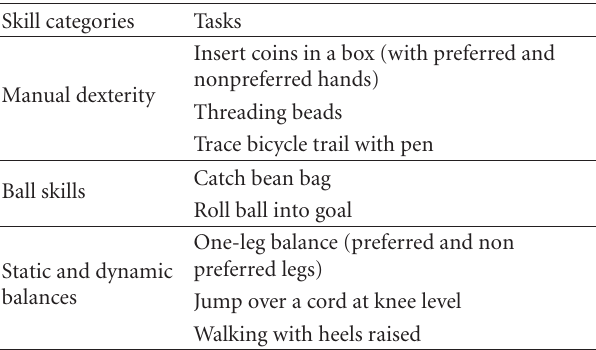
Table 1: Skills quantified by the Movement ABC. Skill